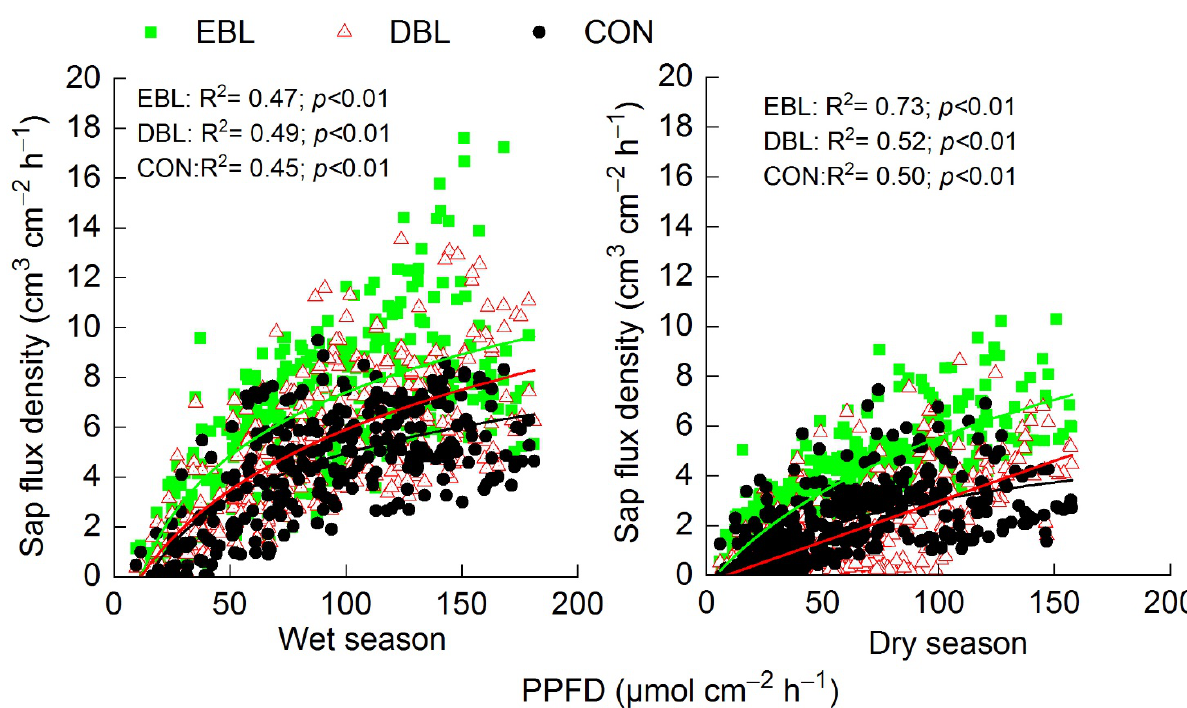
Figure 5. Responses of daily averaged sap flux densities of evergreen broad-leaved trees (EBL), deciduous broad-leaved trees (DBL), and conifers (CON) to PPFD in the wet and dry seasons between May 2016 and March 2019.